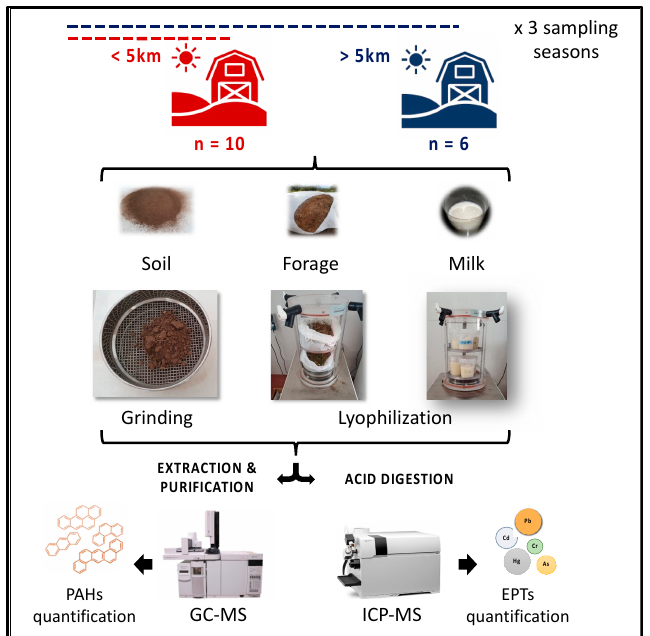
Figure 1. Sampling collection and processing of soil, forage, and tank milk from the selected farms.